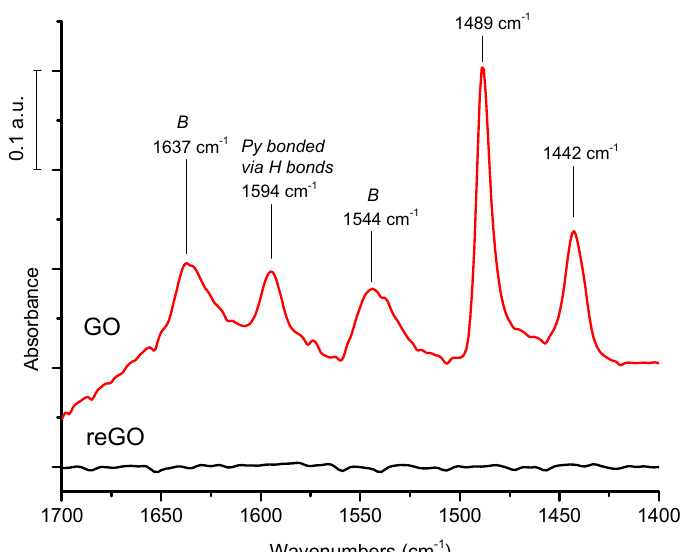
Figure 2. Pyridine adsorption on GO and reGO pretreated for 1 h at ambient T and further vacuum treatment at ambient T for 1 h.